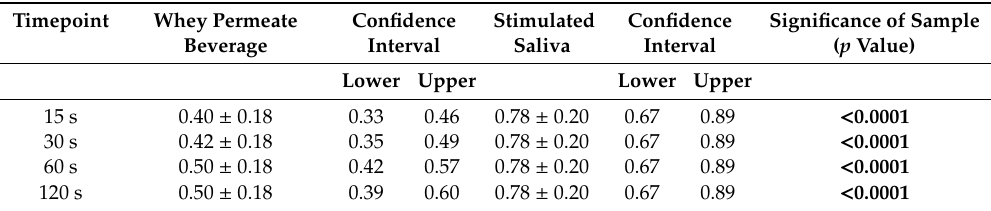
Values are expressed as LSM estimates ± standard error from SAS output. Table A2. Examples of protein concentration (mg / mL) of whey permeate beverage and baseline stimulated saliva values with corresponding 95% confidence intervals.